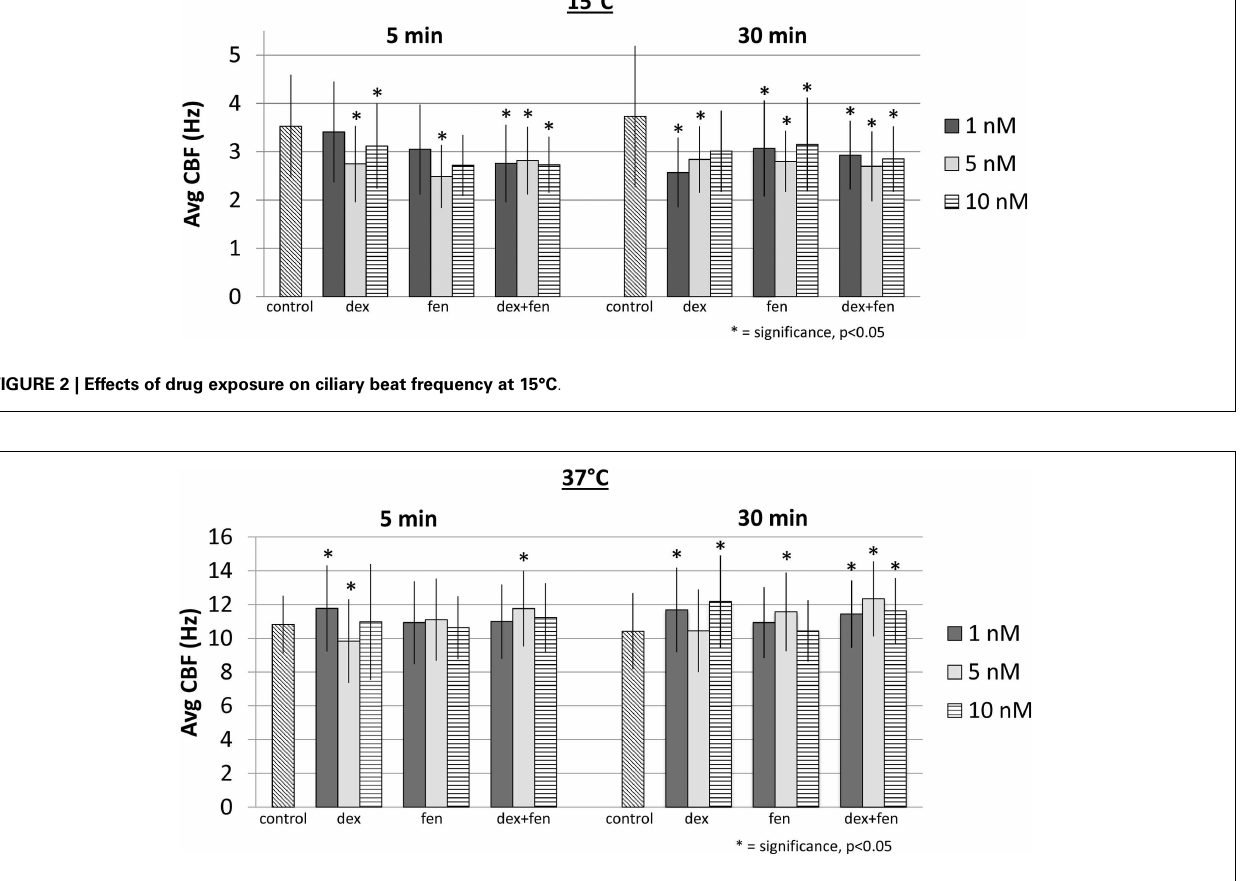
FIGURE 3 | Effects of drug exposure on ciliary beat frequency at 37°C